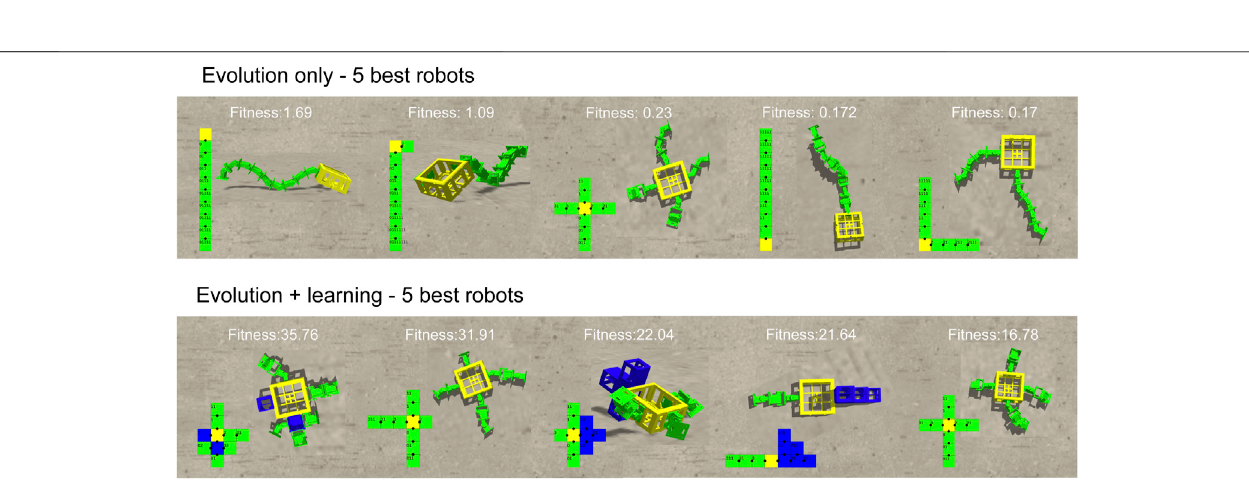
FIGURE 13 | The 2D and 3D morphologies of 5 best robots from both methods. The best robots generated by Evolution + Only are all converged into the morphology type that only contain hinges and no more bricks while the best robots from Evolution + Learning are more diverse. From the 3D morphologies we can see that therobots fromEvolution-Only areevolved withonelayerwhile therobots from Evolution+Learningaredeveloped in thehorizontal dimension as well. With regards to the fi tness, robots from Evolution-Only are suffering from local optimum. In these 10 robots, we observe a same morphology from both methods (cross-shape), however the robot from Evolution + Learning has a much higher fi tness value, once again it shows the importance of matching body and brain.